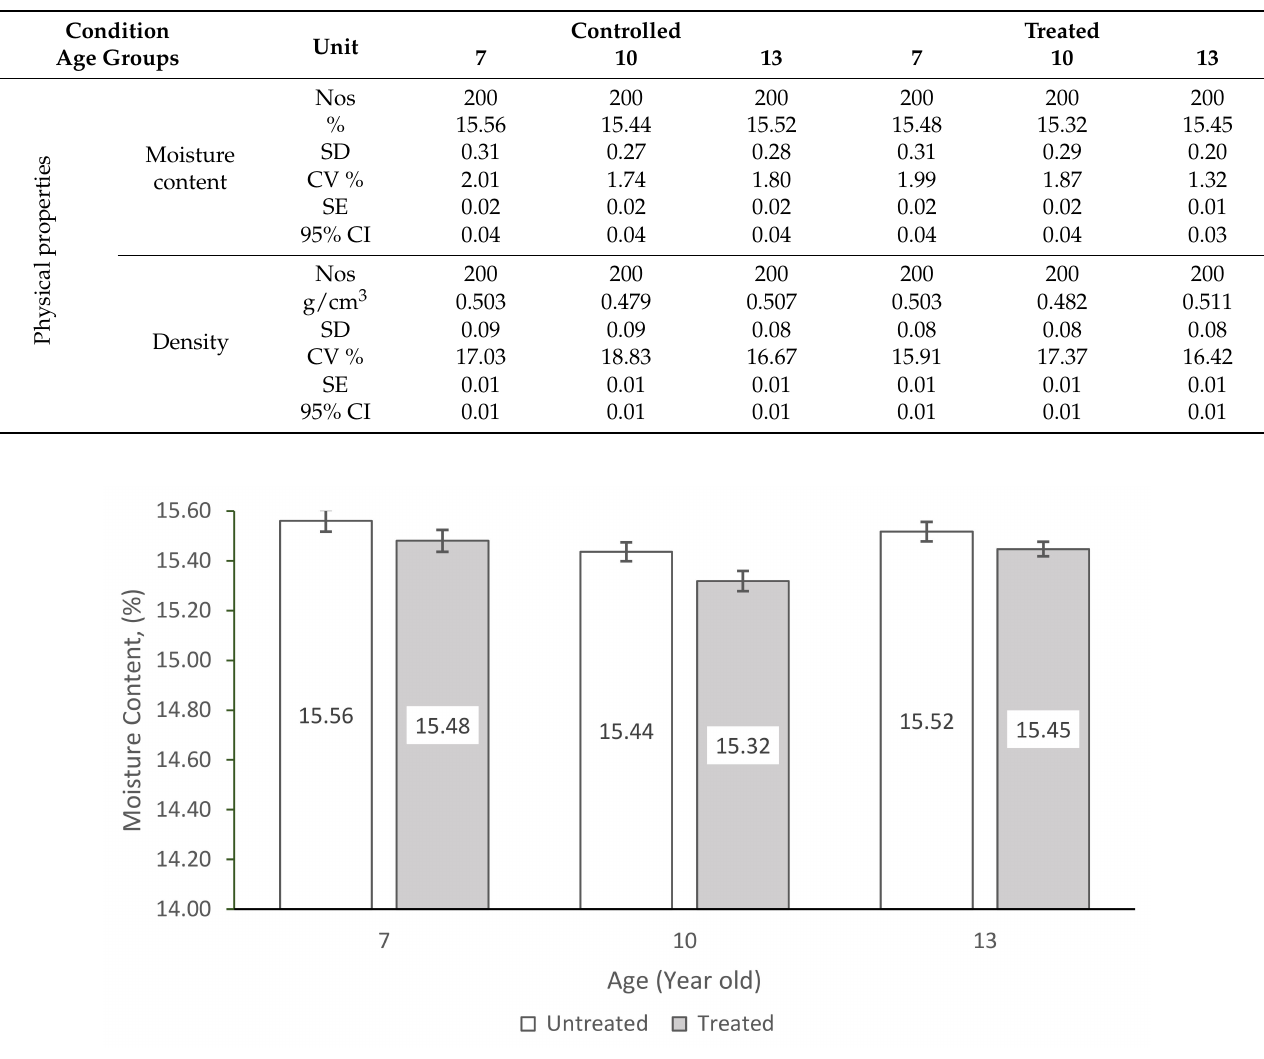
Table 2. Summary of the mean moisture content and density of Acacia hybrid.